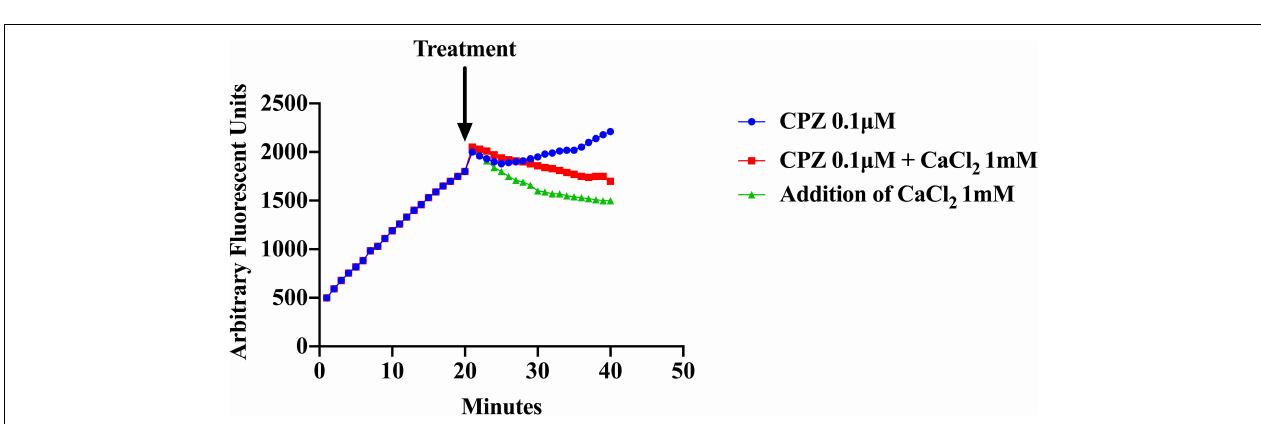
FIGURE 4 | Ethidium bromide accumulation in response to CaCl 2 , Ca 2 + -inhibitors and a proton uncoupler at pH 5 and pH8. Efflux activity of S. aureus cells was measured under different pH conditions, calcium and inhibitors. (A) S. aureus cells were preincubated in the presence of two Ca 2 + concentrations (1 mM and 5 mM), glucose (0.4%), and CCCP (50 µ M) was added to disrupt the electrochemical gradient (pH 5). (B) EtBr efflux measured at pH 8, with CaCl 2 (1 mM and 5 mM), 0.4% glucose, the phenothiazine CPZ (0.1 µ ), and EDTA (10 mM). The results represent an average of three replicates. Significant differences were found between the treatments using a non-parametric Kruskal–Wallis test ( p < 0.0001).